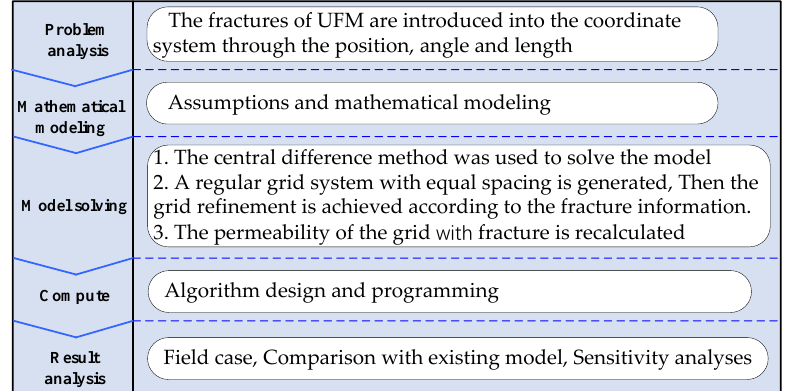
Figure 1. The flowchart with detailed procedure of the new method.